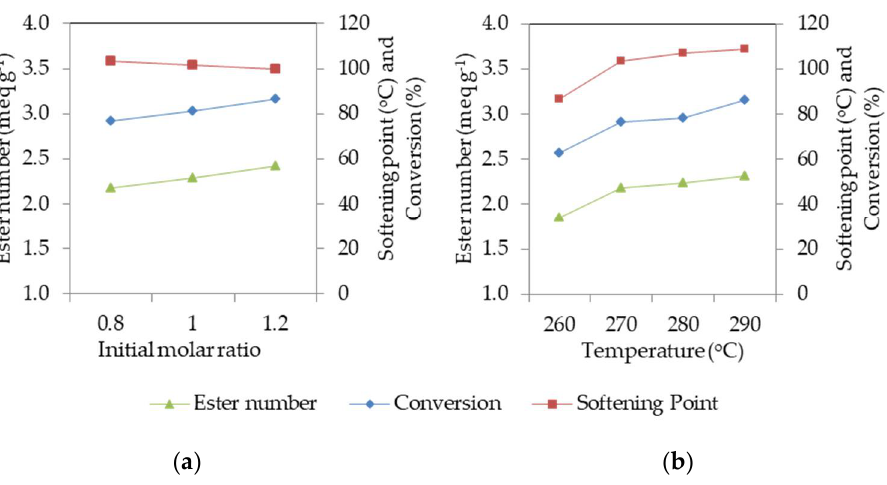
Figure 3. The conversion of rosin, ester number and softening point of RPE versus ( a ) molar ratio of pentaerythritol to rosin, at 270 °C and ( b ) temperature, with the ratio of 0.8 in 4 h reaction time.